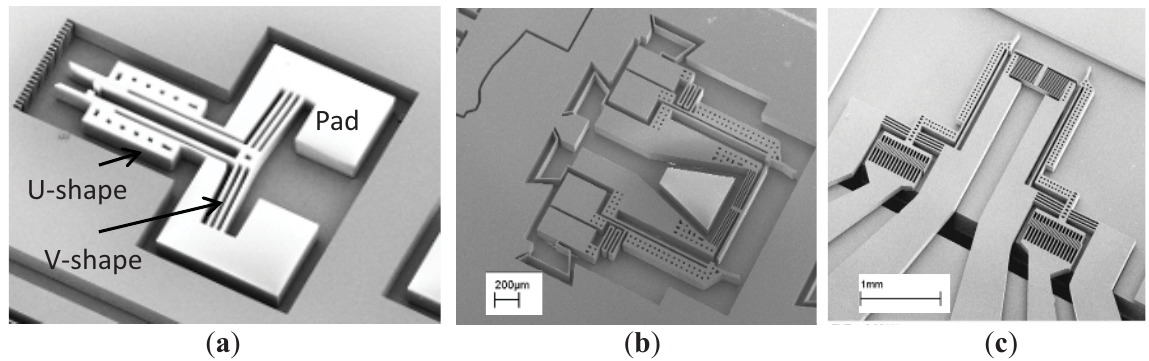
Figure 1. Examples of E-T end-effectors fabricated on Silicon On Insulator (SOI) material: ( a ) Micro grasper (combining bent-beam and folded-beam mechanisms) [7]. ( b ) The end-effector has grasper (obtained from folded beam mechanism), micro-heater (obtained from bent beam structure), and positioning sensor (obtained from resistive Zigzag structure); ( c ) A packaged end-effector incorporates multifunctional sensing and actuation